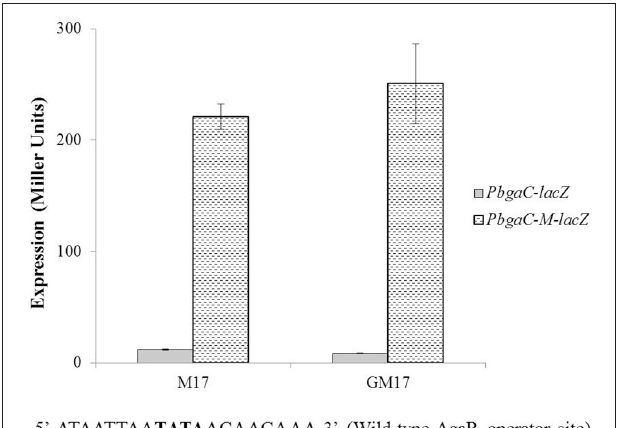
FIGURE 4 | Expression levels (in Miller units) of P bgaC-lacZ and P bgaC-M-lacZ in D39 wild-type grown in M17 (with no added sugar) and GM17 (0.5% Glucose + M17). Standard deviations of three independent experiments are indicated in bars. Wild-type and mutated AgaR operator sites in P bgaC are given below.